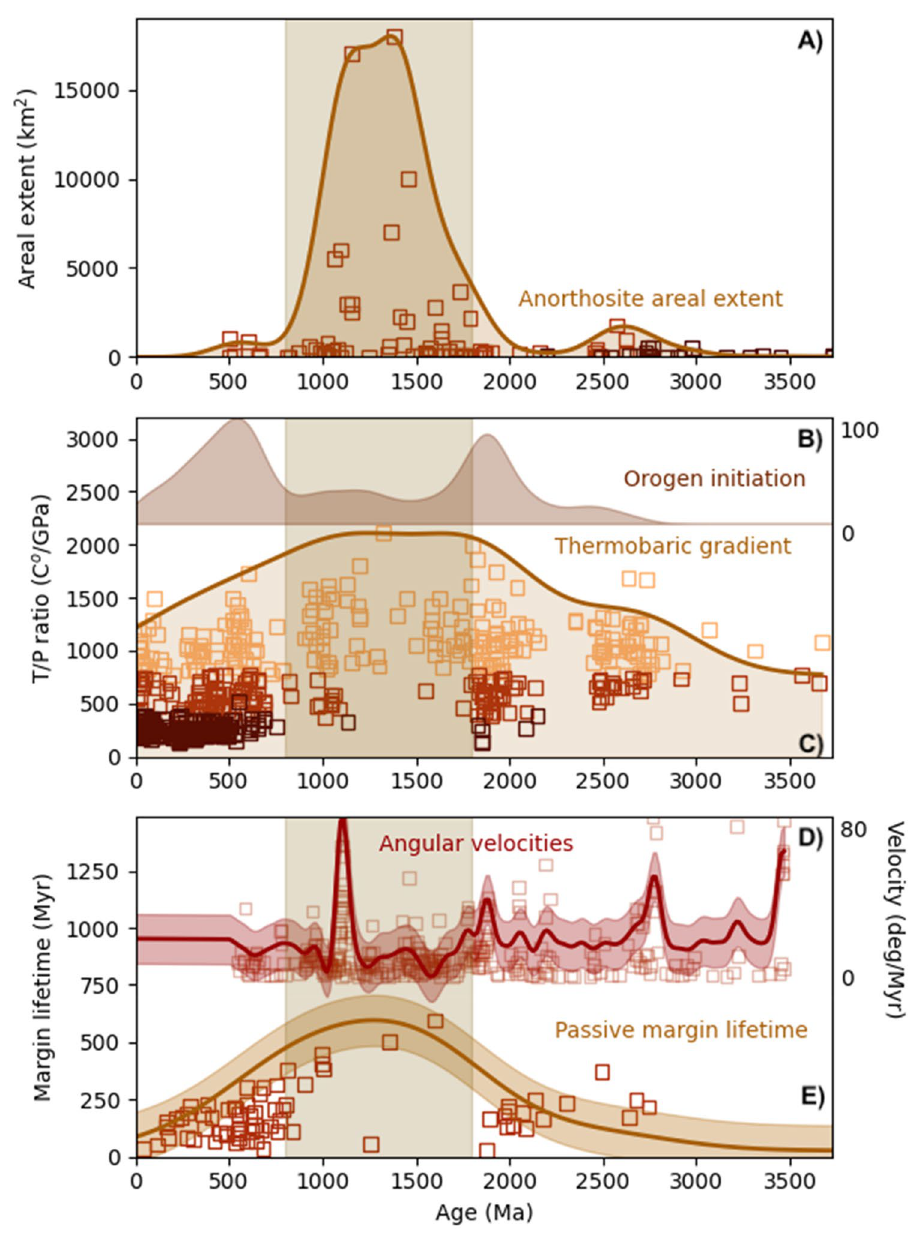
Figure 1. Compilation of constraints on intraplate magmatism, metamorphism and plate dynamics back to the beginning of the Archaean. The period of the "boring billion" from 1.8 to 0.8 Ga is shaded. ( A ) Distribution of anorthosites through time 15 , plotted by areal extent, and a weighted kernel distribution function (kernel width 200 Myr). ( B ) Top shows the weighted kernel density estimate of orogen initiation through time, from the data of Condie 20 (top, kw = 167 Myr). Bottom shows thermobaric ratios ( T/P ) of metamorphism through time, from Brown and Johnson 19 . Shown are data from high T/P localities (including UHT metamorphism (T > 900 °C)) in orange, intermediate T/P localities (red), and low T/P localities (maroon, including UHP metamorphism). Shaded curve shows a weighted KDE ( kw = 500 Myr) through the high T/P data. ( C ) Top shows angular velocities of APW paths, compiled from a Monte-Carlo sampling of compiled pole paths for the Slave, Superior (plus east Superior), Baltica, South Australian, Kaapvaal, Pilbara, Wyoming and North China blocks (see Supplementary for statistical details). Red line and shaded region show weighted KDE of the data ( kw = 100 Myr). Bottom shows the lifetime of passive margins from Bradley 7 , and weighted KDE ( kw = 600